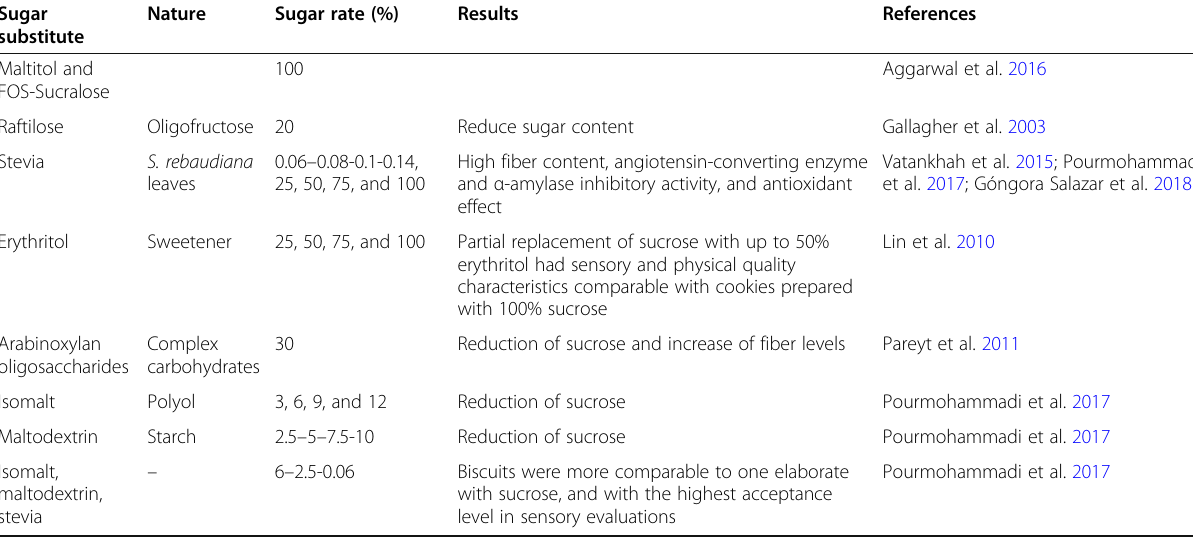
Table 2 Sugar substitutes and their potential effect on biscuit quality Sugar